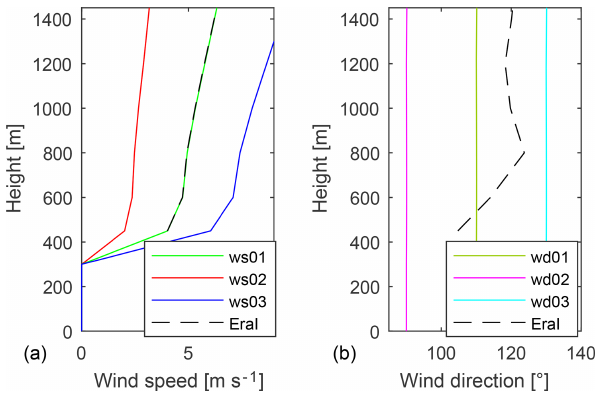
Figure 3. Mean wind speed (a) and wind direction (b) profiles in the three considered scenarios and sensitivity experiments. In addition, the original ERA-Interim profiles (ERAI) are given as dashed lines.